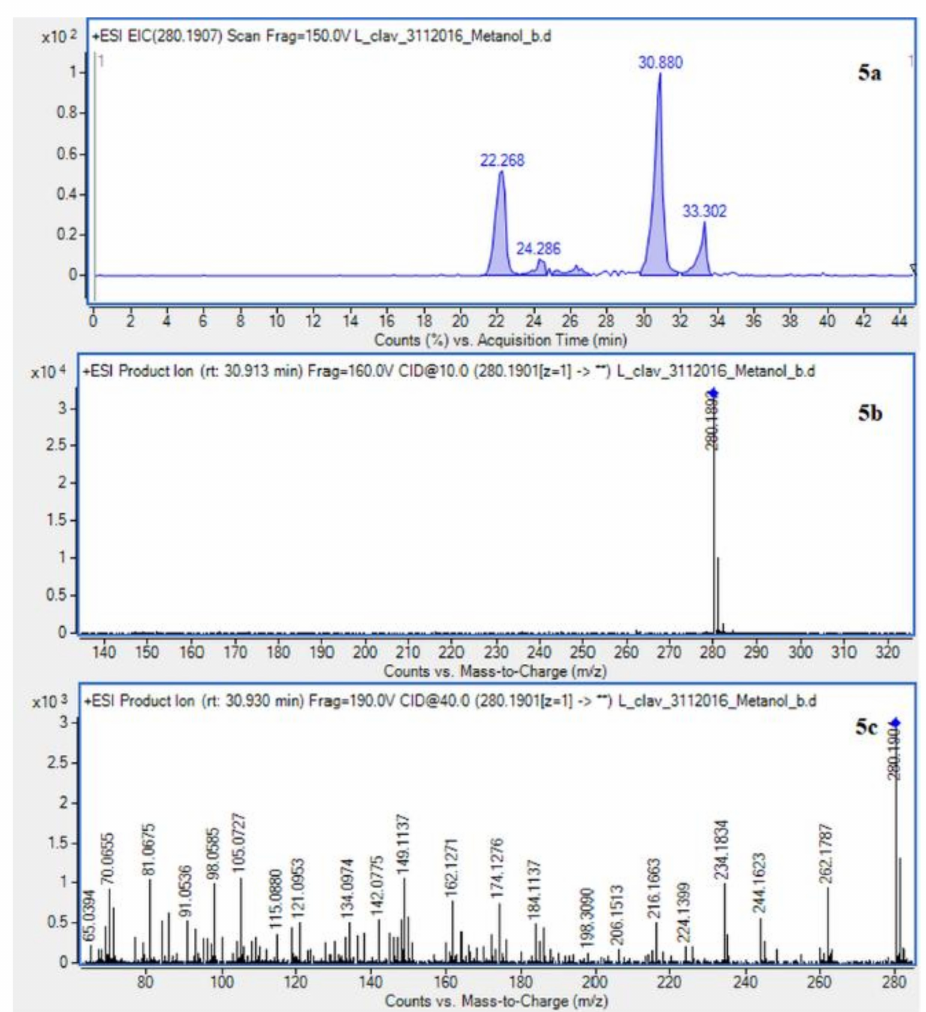
Figure 3. Extracted ion chromatogram (EIC) of L. clavatum methanolic extract determined by HPLC/ESI-QTOF–MS showing identified alkaloids: ( 1a )-annofoline at m / z 264.1958; ( 2a )- dihydrolycopodine at m / z 250.2165; ( 3a )-lycopodine at m / z 248.2009; ( 4a ) deacetylfawcettiine at m / z 266.2115 and ( 5a ) 8- β ,11- α dihydroxylycopodine (or epimer) at m / z 280.1907. Below CID MS/MS product ion spectra using 10 eV ( b ) and 40 eV ( c ) of collision energy showing the protonated molecules fragmentation